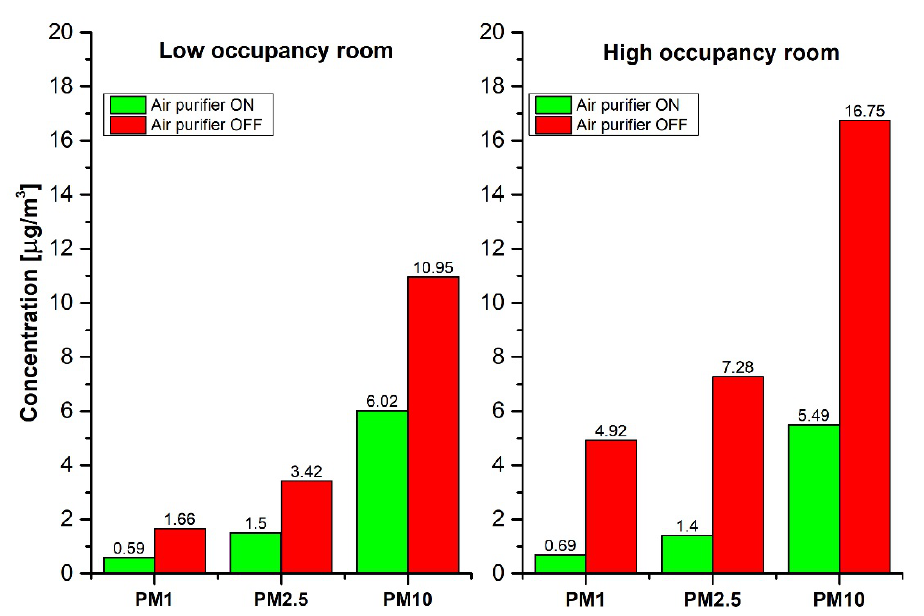
Figure 9. Correlation among PM readings of the AlphaSense OPC-N3 monitor. The data represent all measurements for one representative day. Similar results were obtained for the remaining single days, as well for the whole set of data.